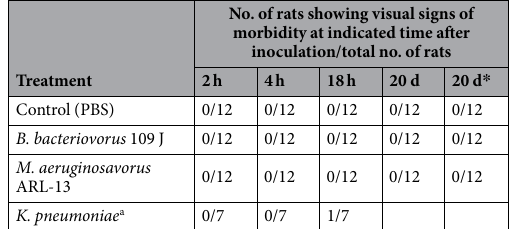
Table 1. Numbers of rats showing visual signs of morbidity after tail vein injection with predatory bacteria * Rats were inoculated a second time at 10 days post-infection to model a multiple bacteremia event. a With animal well-being in mind, rats inoculated with K . pneumoniae were not kept past 18 h